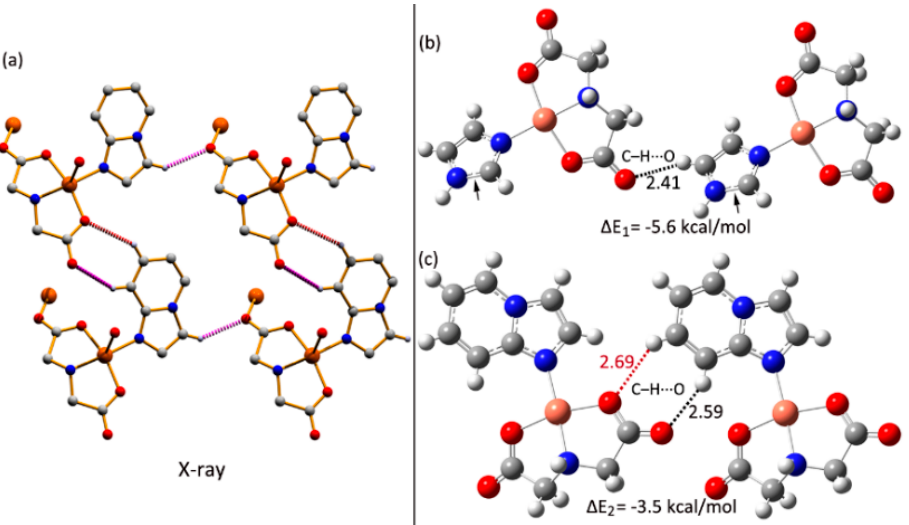
Figure 7. ( a ) X ‐ ray fragment. ( b , c ) theoretical models used to estimate the formation energies.